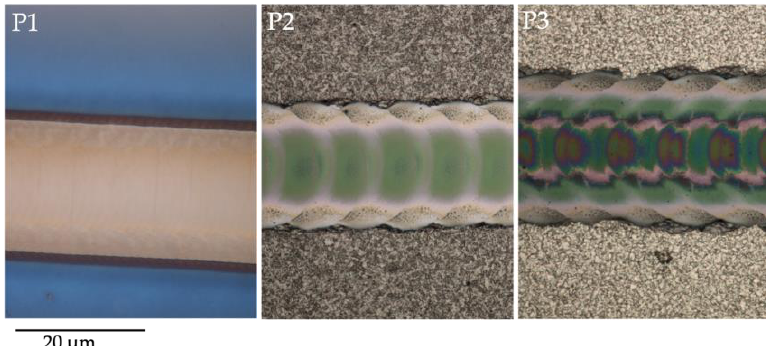
Figure 12. Optical microscope pictures of P1-P2-P3 scribes taken with a magnification of 1000 × ; P1, P2 and P3 cut TCO, CdS/CdTe and back-contact layers, respectively. Substrate is a 3.3 mm thick SLG.